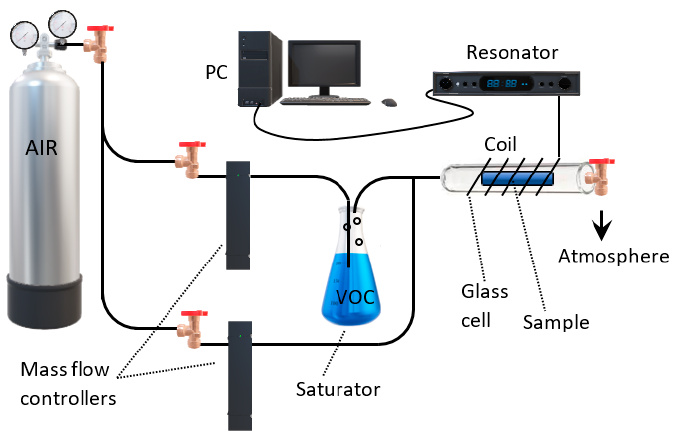
Figure 2. Experimental set-up for the detection of volatile organic compounds (VOC).